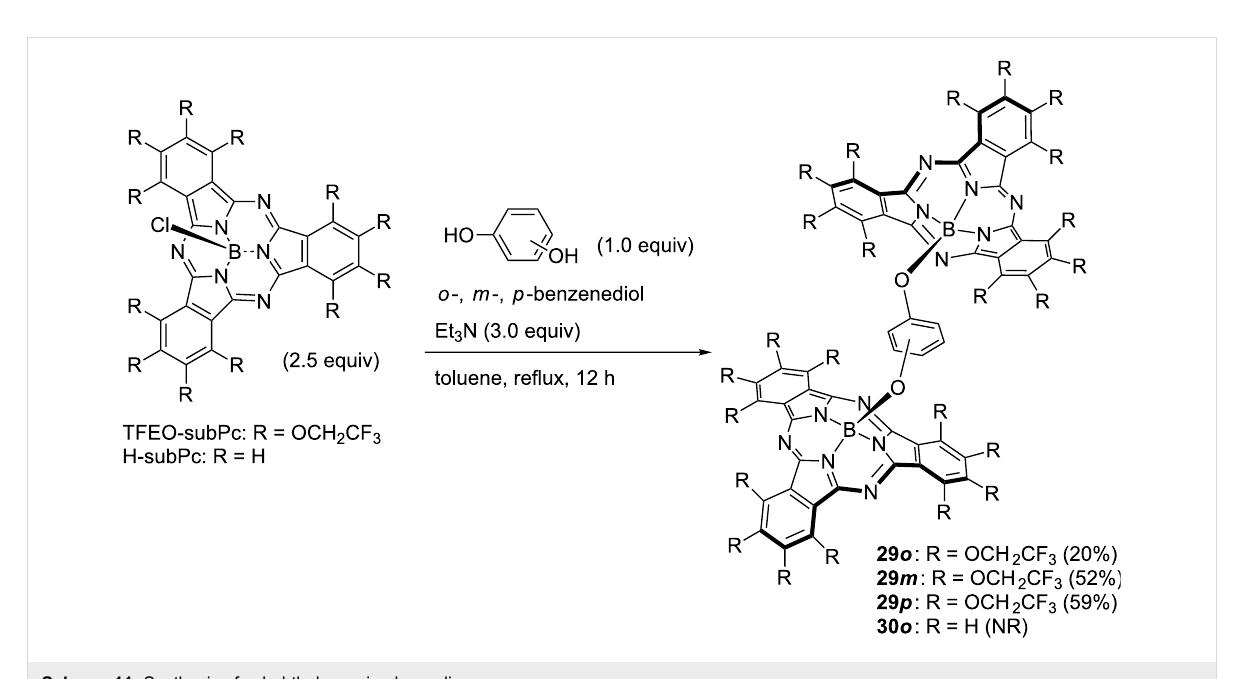
Scheme 11: Synthesis of subphthalocyanine